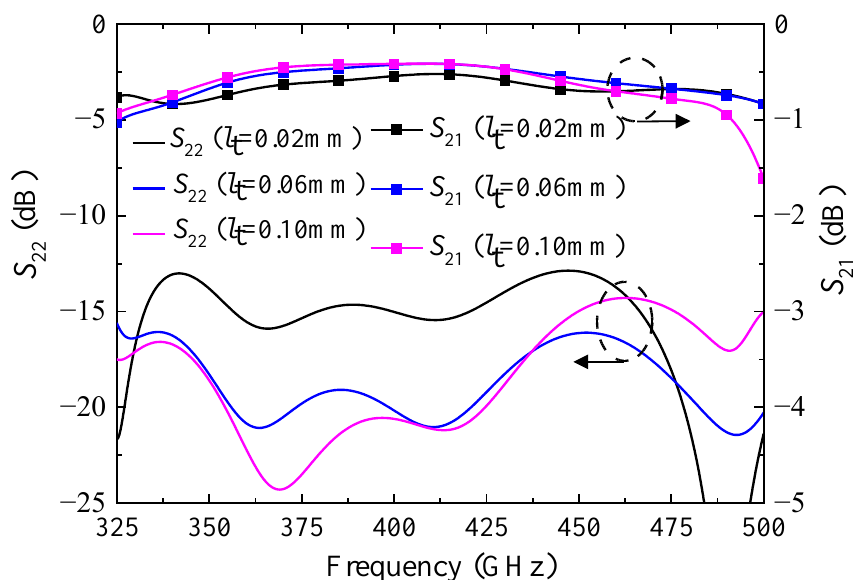
Figure 6. Simulated S -parameters of the proposed transition with different l t (Solid lines represent S 22 ; lines with square symbols represent S 21 ).